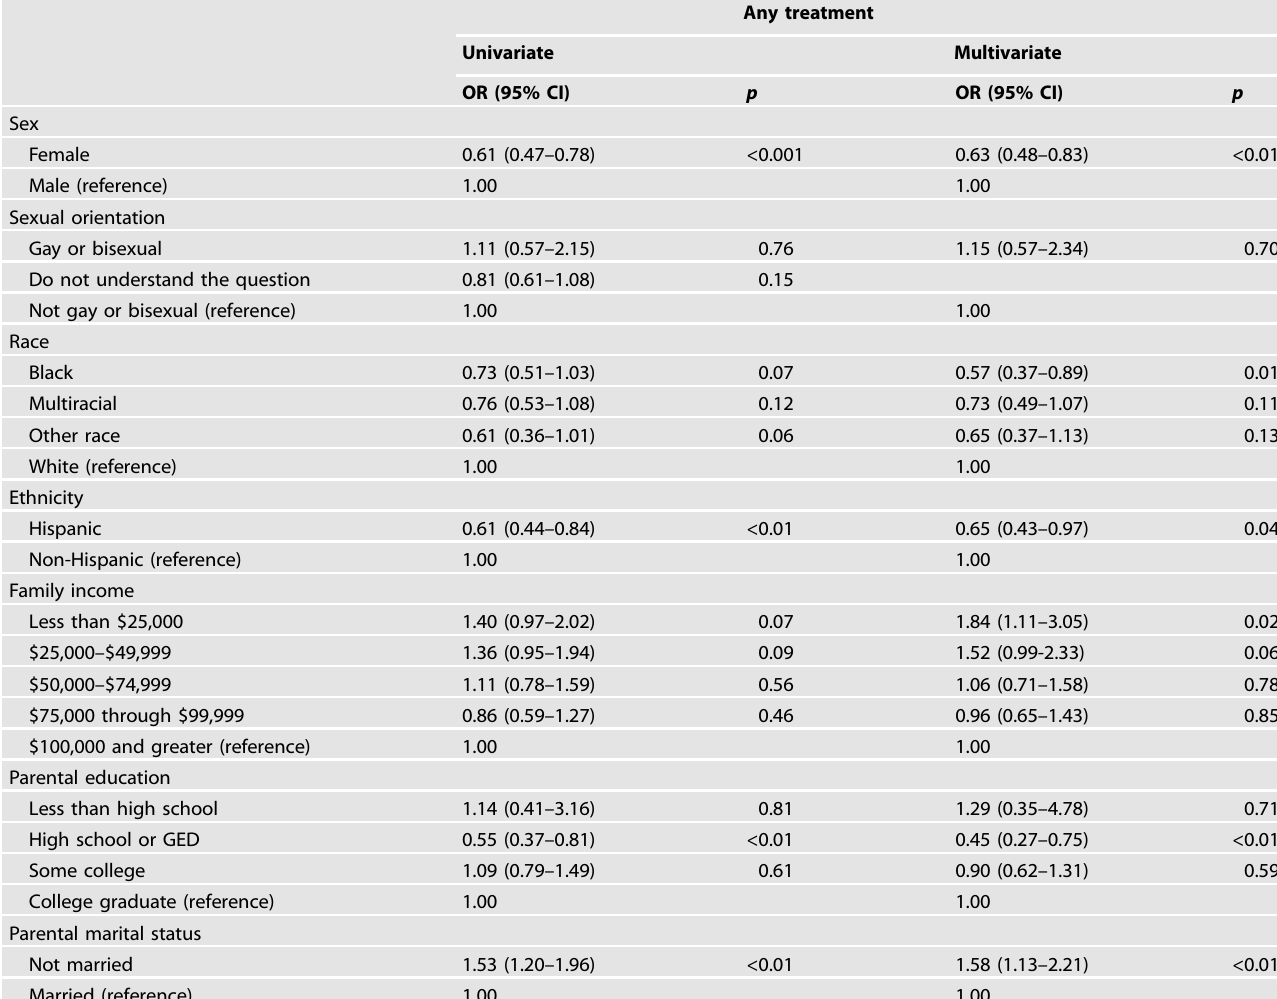
Table 4. Sociodemographic predictors of psychiatric treatment utilization among children with lifetime history of pure suicidal ideation (unweighted n =